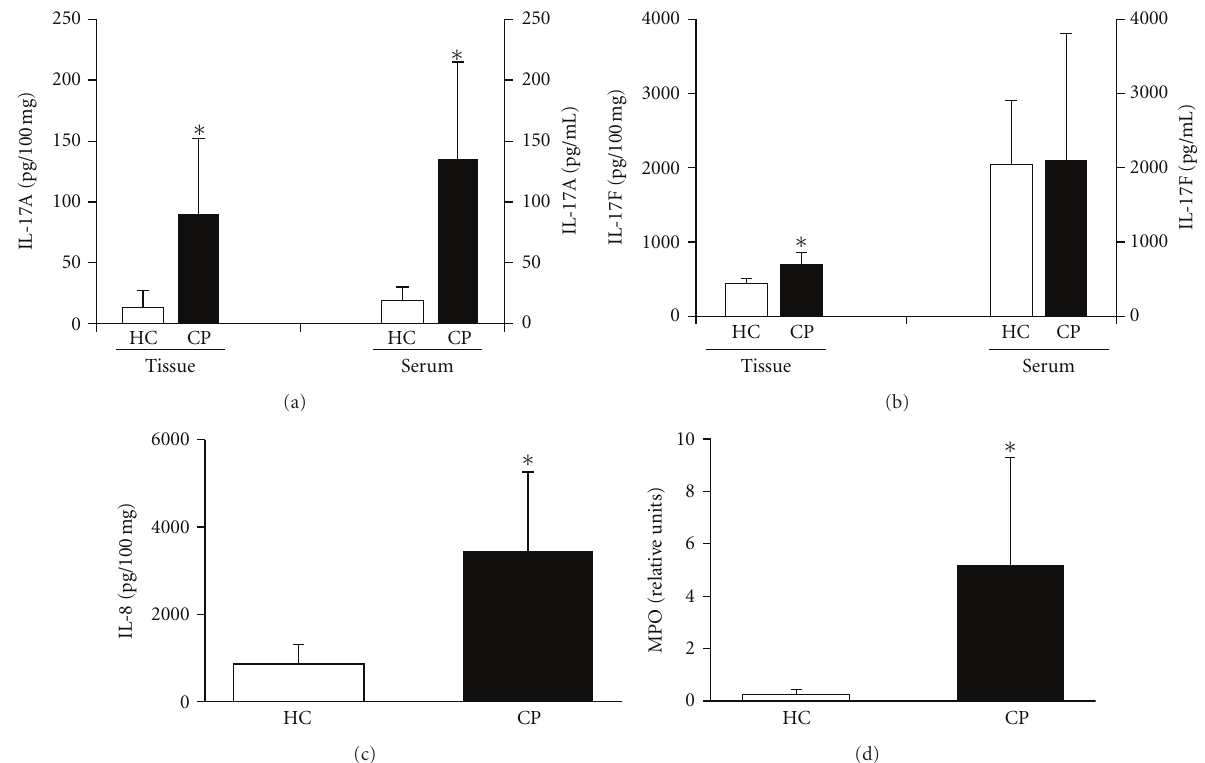
Figure 1: Levels of (a) IL-17A and (b) IL-17F in the gingival tissue and serum samples from CP and HC subjects. (c) Levels of IL-8 and (d) MPO activity in gingival tissue samples from CP and HC subjects. ∗ Statistically significant di ff erence at P < 0 . 05. HC: healthy control, CP: chronic periodontitis, and MPO: